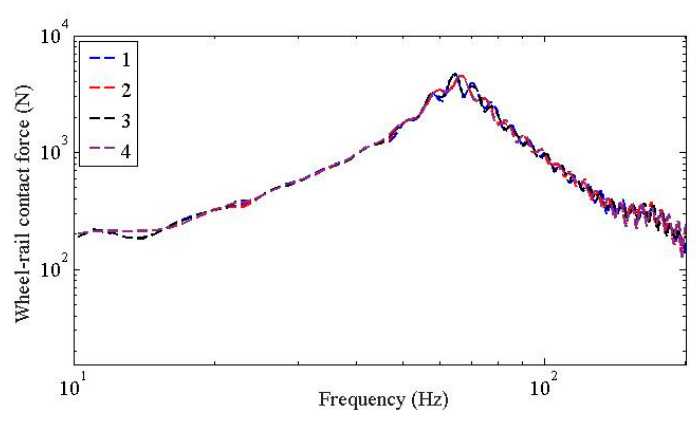
Figure 16. Wheel-rail contact force for wheel 1, 2, 3, and 4.